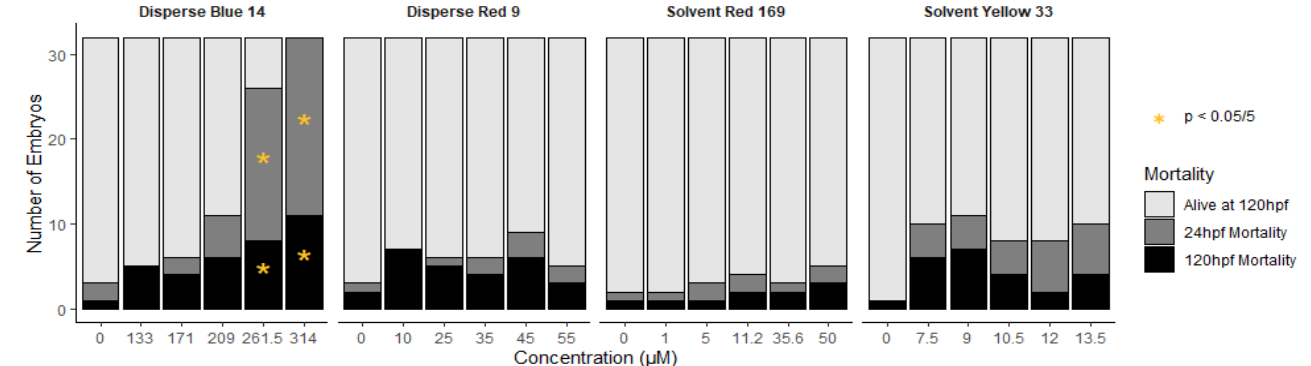
Figure 1. Summary of mortality at 24 and 120 hpf in Disperse Blue 14, Disperse Red 9, Solvent Red 169 and Solvent Yellow 33 treatment groups. * Indicates statistical significance ( p < 0.05/5).